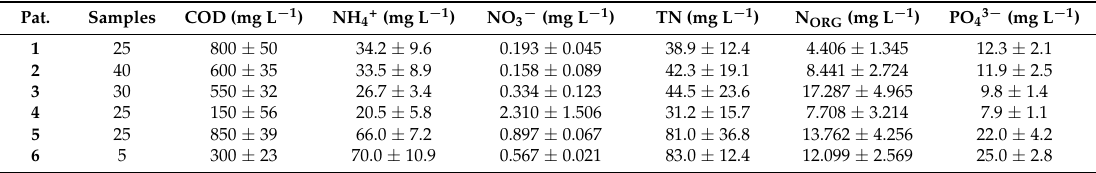
Table 2. Characterization of the six pollution patterns related to organic matter and nutrient content. Pat.